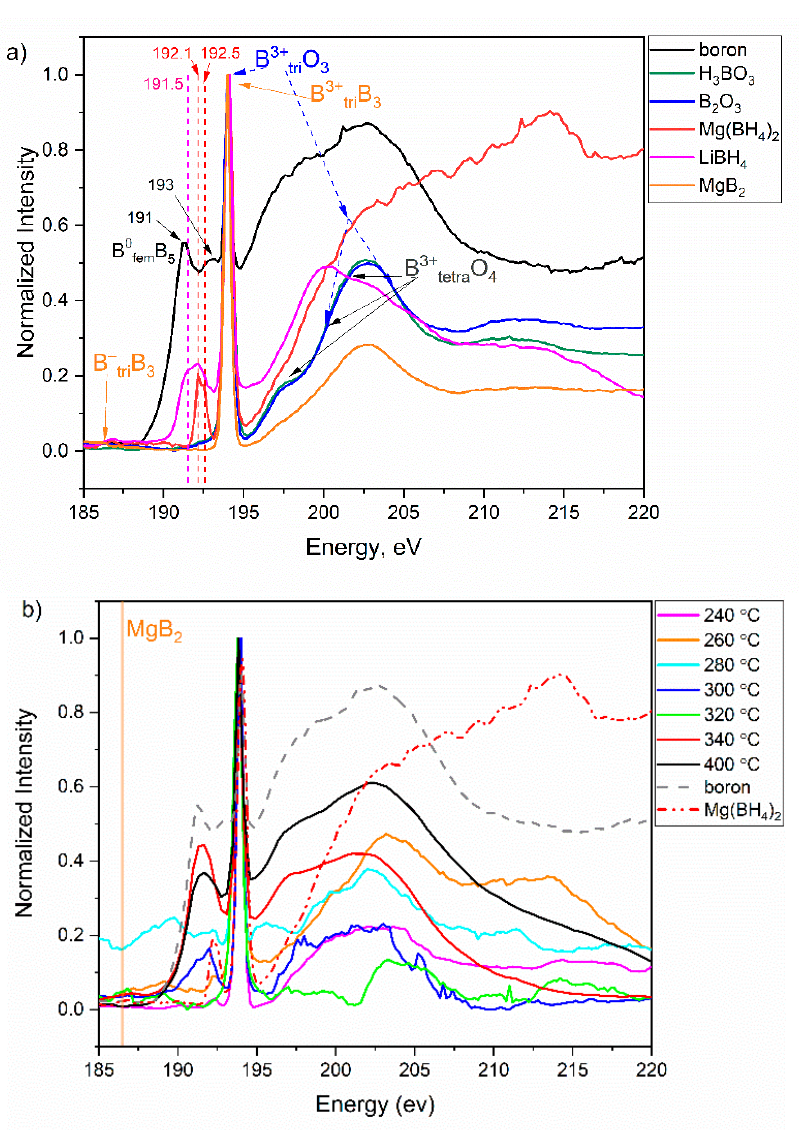
Figure 5. B K-edge NEXAFS spectra of ( a ) boron-based reference compounds, ( b ) samples decomposed at various temperatures.